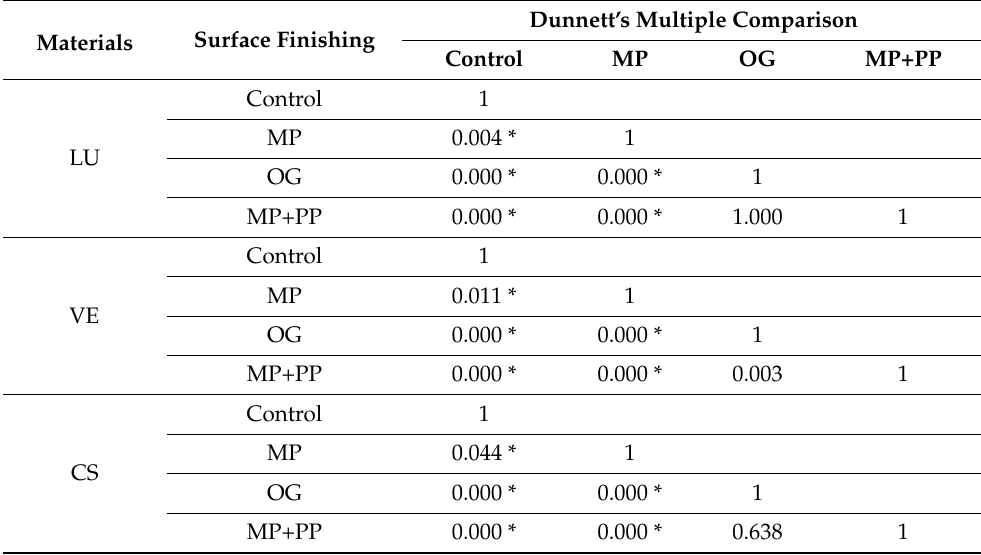
Table 8. Post hoc multiple comparisons for BFS of the materials after surface